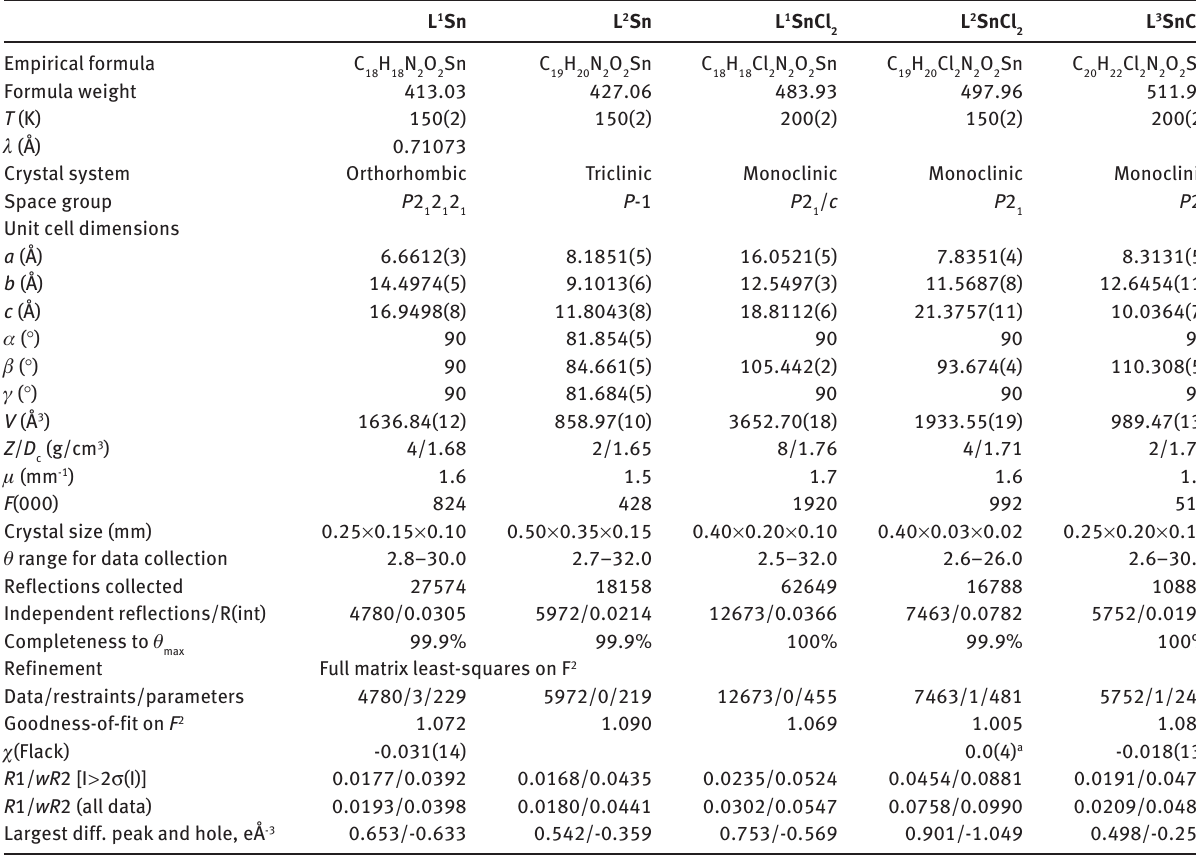
, L 2 SnCl and L 3 SnCl . 2 2 2